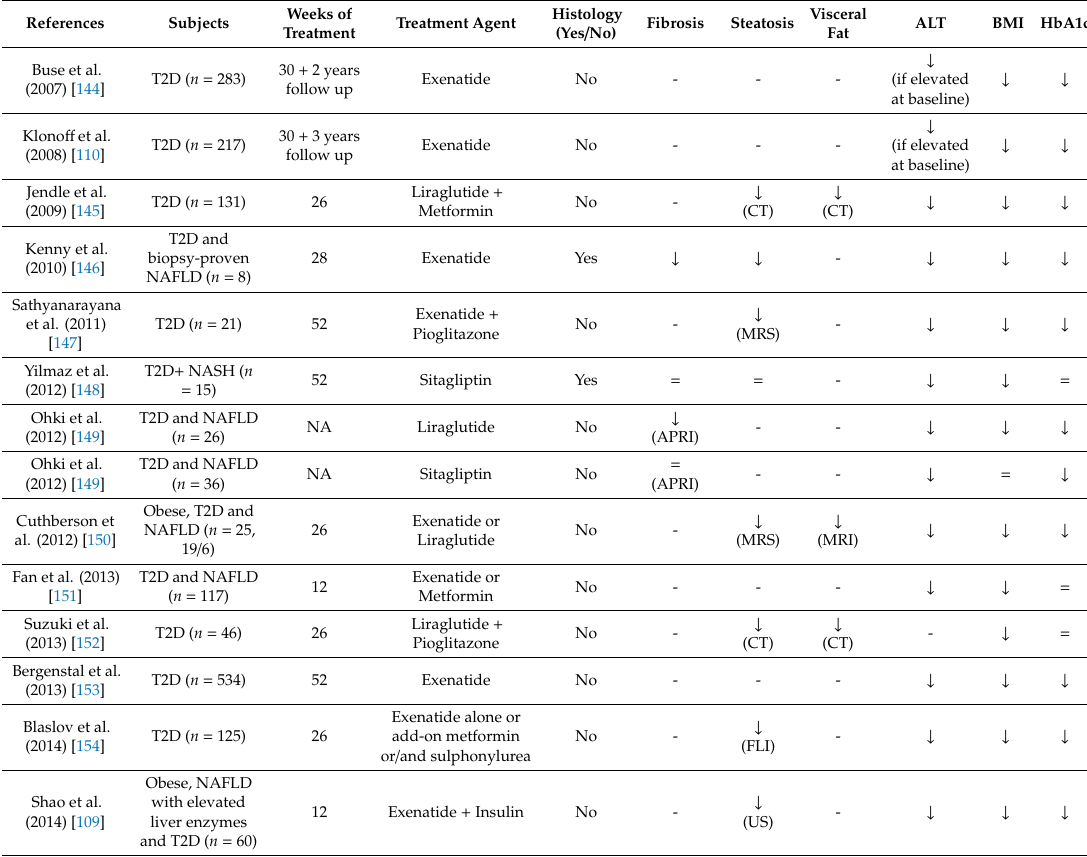
Table 2. Liver-related outcome e ff ects of treatment with GLP-1RA or DPP-4 inhibitors in